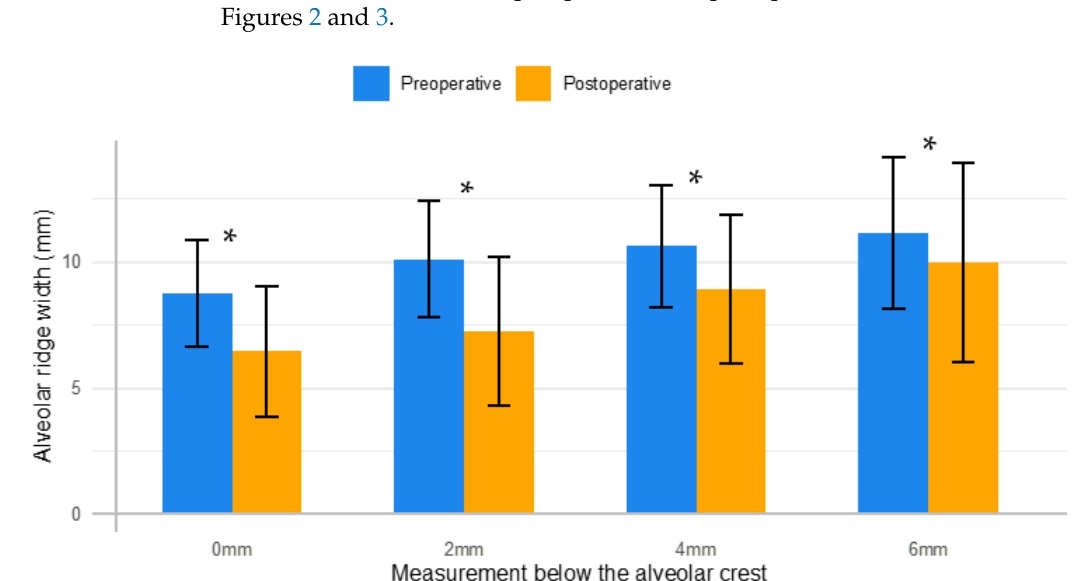
Figure 2. Alveolar ridge width measurements. Mean width of the alveolar ridge preoperatively (blue) and postoperatively (orange) is shown at crestal level (0 mm), 2 mm, 4 mm and 6 mm below the crest. * Statistically significant mean difference ( p < 0.05).